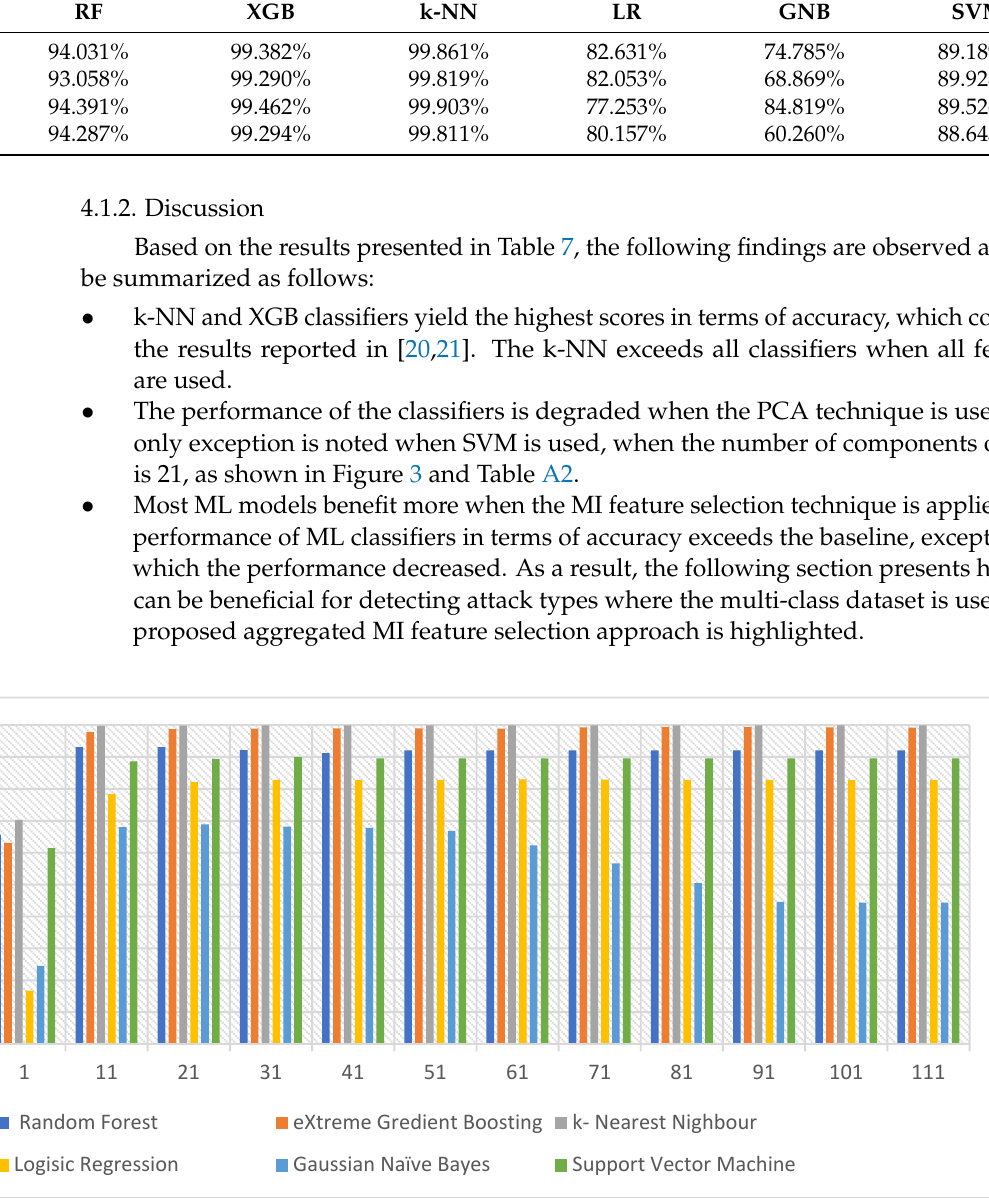
Figure 3. Accuracy of the ML model with respect to different PCA components.